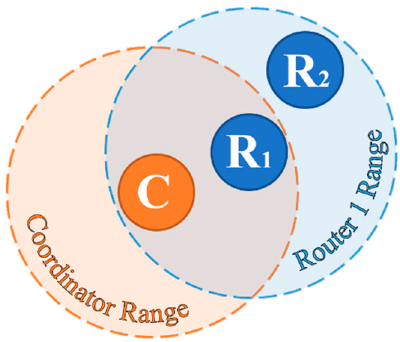
Figure 12. Representation of Case A.3.